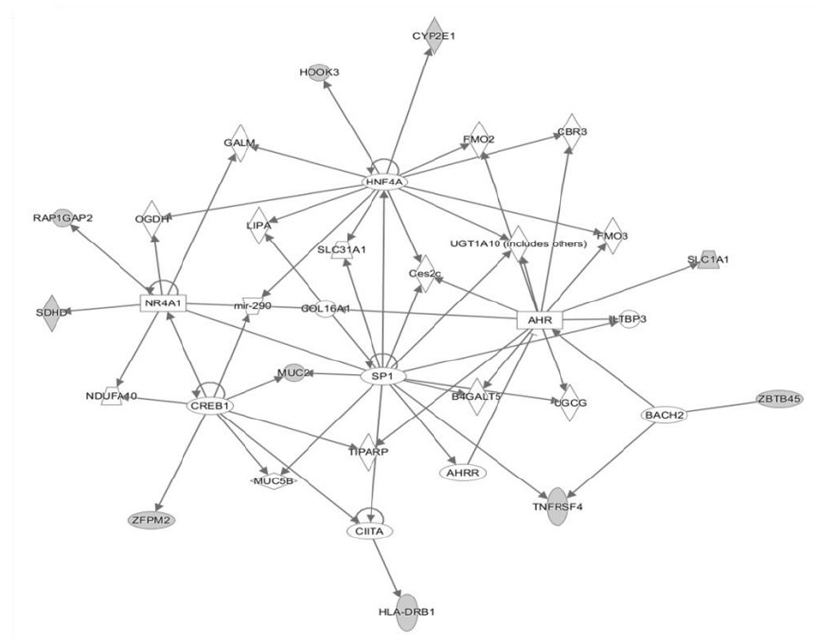
Figure 4. Gene network of interactions related to more relevant CPGs sites.